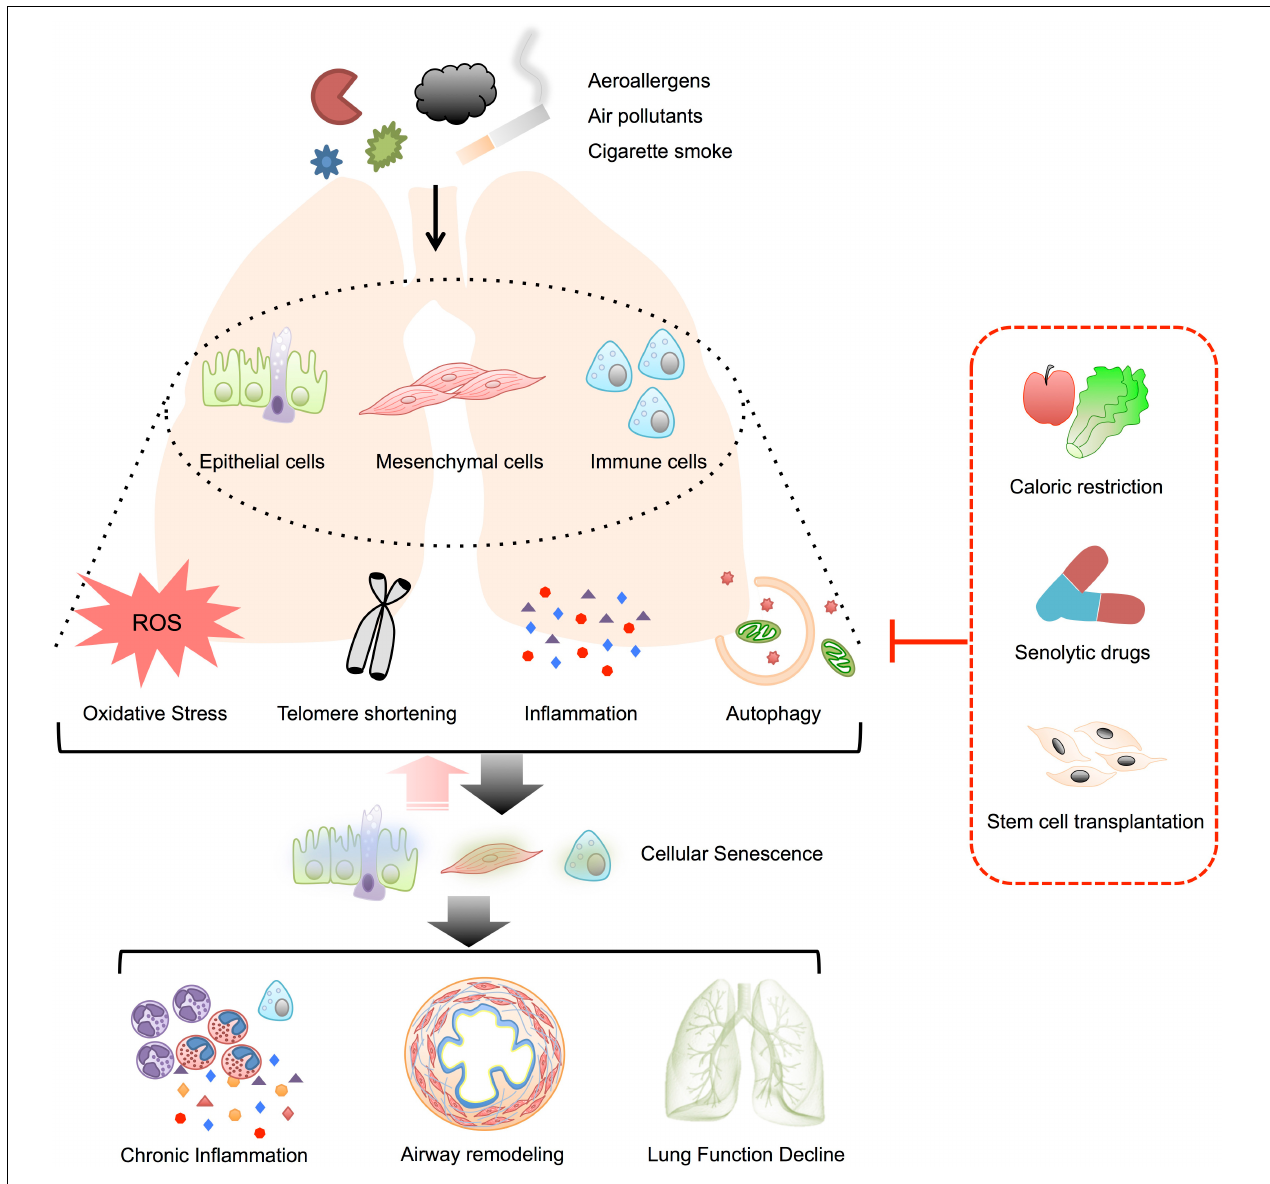
FIGURE 1 | Possible role of cellular senescence in asthma. Telomere damage, oxidative stress, inflammation and insufficient/non-selective autophagy induced by various stimuli might mediate the senescence of airway epithelial cells, mesenchymal cells, and immune cells in asthmatics. The senescent cells could also augment surrounding cell senescence through SASP and form a vicious cycle. The senescence in these target cells would contribute to the pathobiology of asthma, including airway inflammation, airway remodeling as well as lung function decline. By the way of suspending the mediators of cellular senescence, anti-senescence strategies such as caloric restriction, senolytic drugs, and stem cells transplantation might serve as novel therapies for patients with asthma.